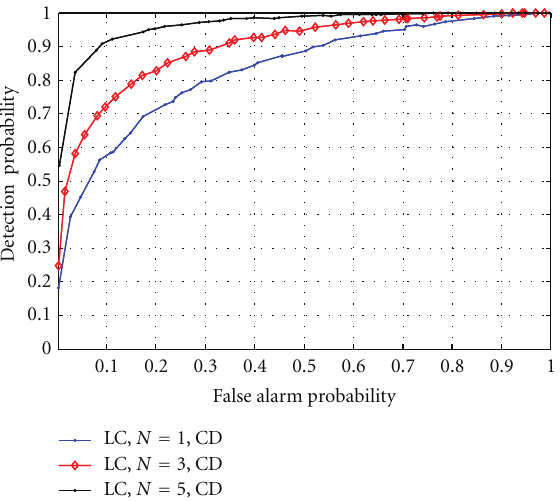
Figure 11: ROC curves of coherent-based linear classifier scheme: SNR avg = − 14dB and L =